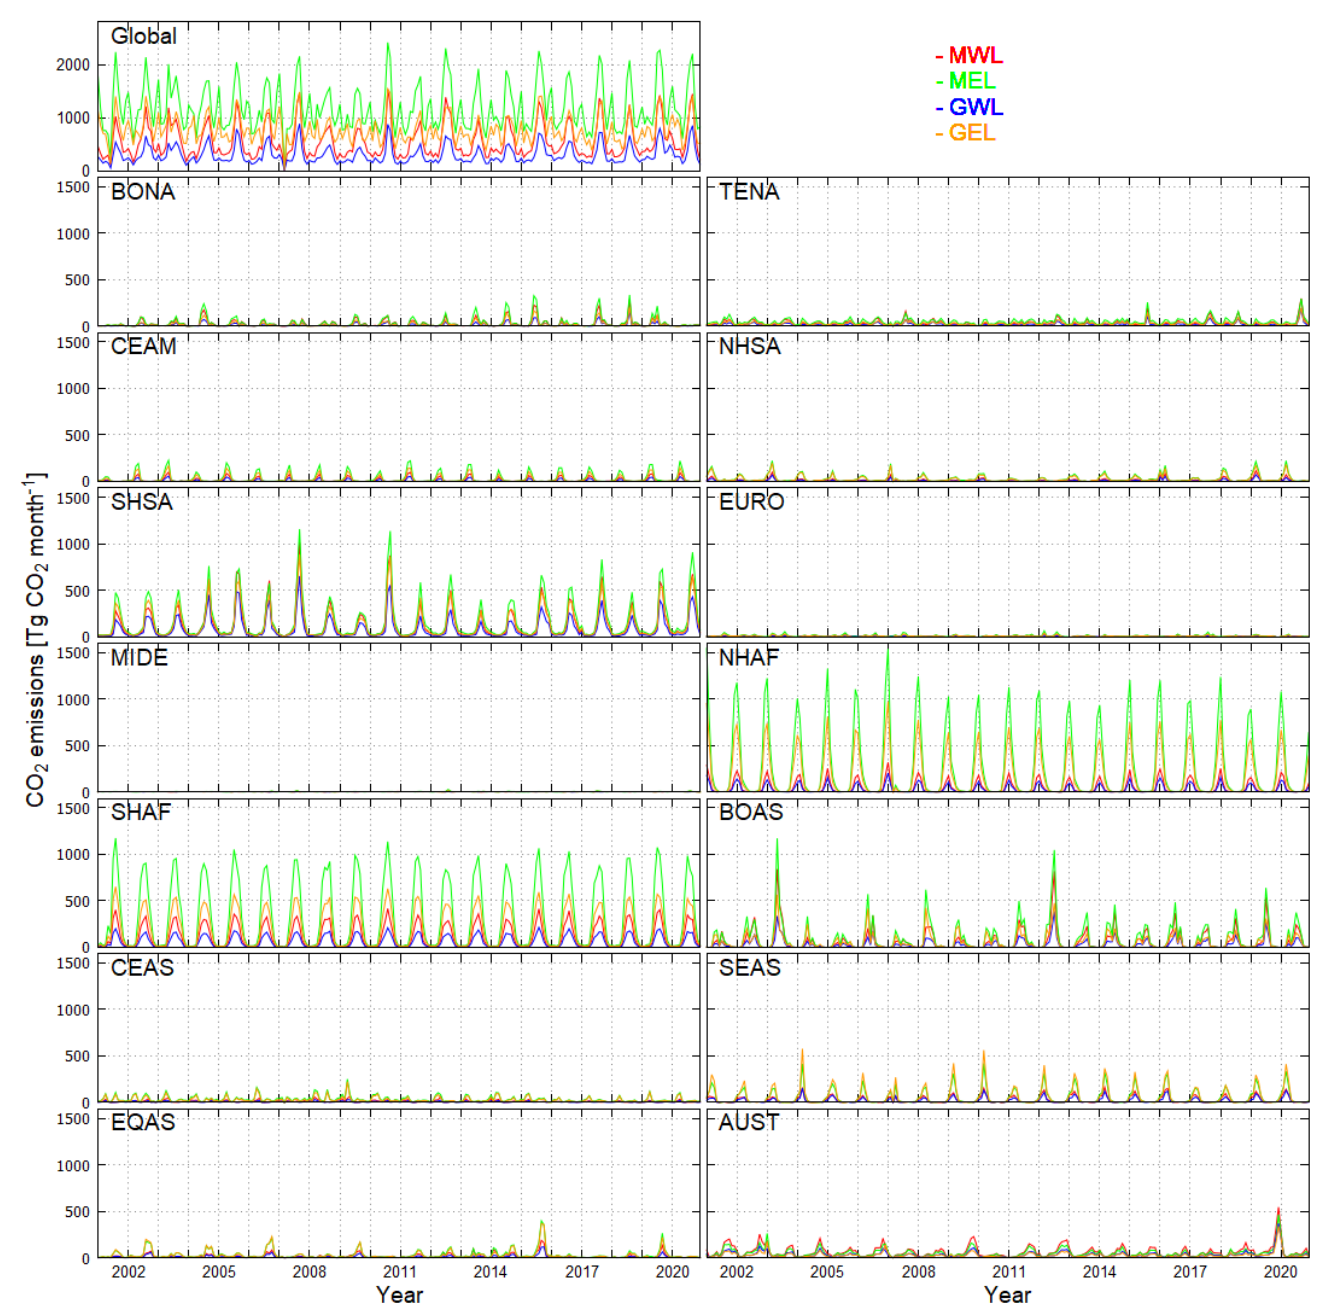
Figure 5. Comparison of the monthly CO 2 emissions by four inventories in each region from January 2001 to December 2020. The compared inventories are MWL (red), MEL (green), GWL (blue), and GEL